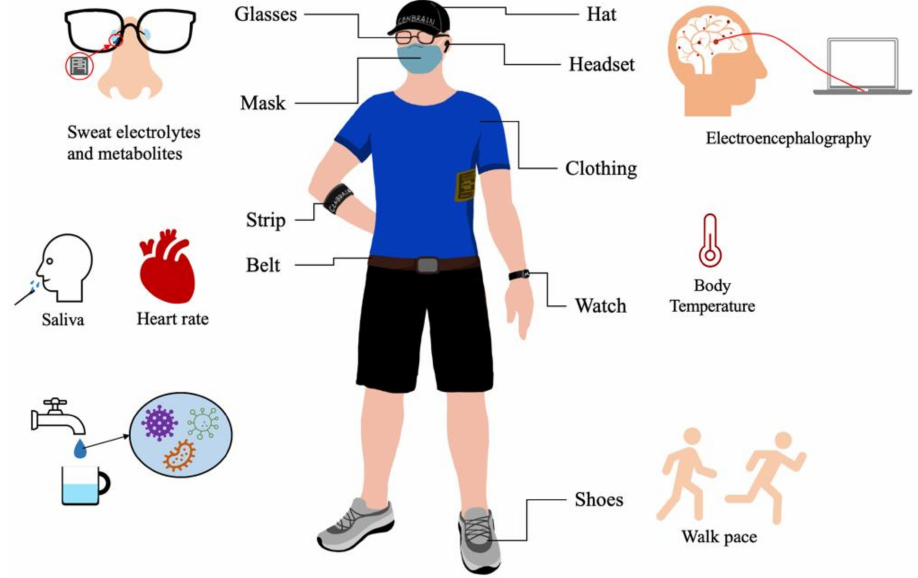
Figure 1. Wearable medical and healthcare devices for various regions of the